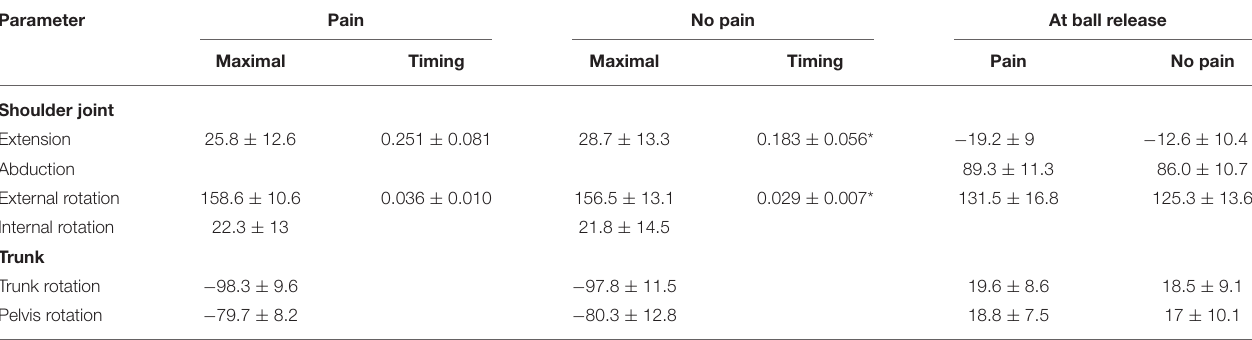
TABLE 2 | Maximal shoulder angles ( ◦ ) ± SD and timing(s) before ball release and joint angles at ball release.